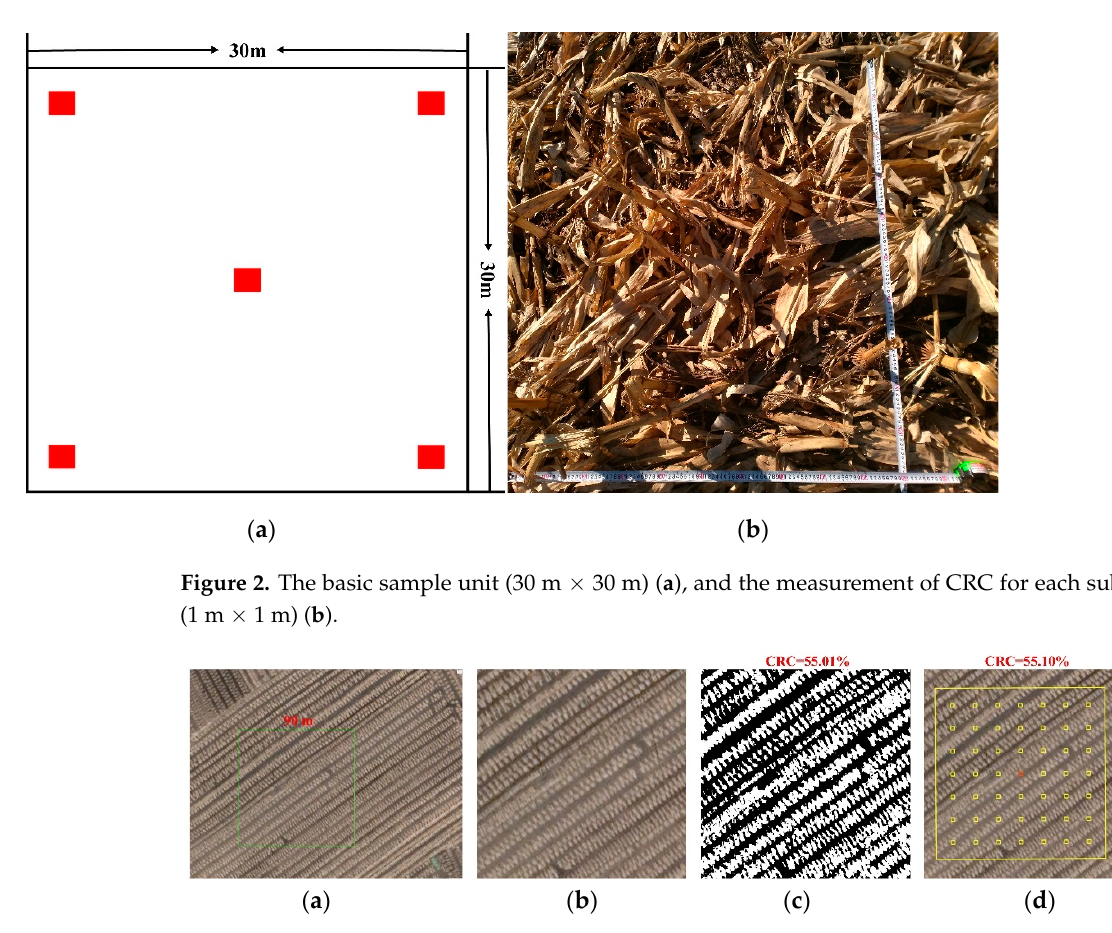
Figure 3. Illustration of the CRC assessment method using thresholding of Google Earth imagery: ( a ) Google Earth image chip, ( b ) 90 × 90 m Google Earth image chip, ( c ) CRC obtained by threshold- ing, ( d ) CRC collected on the Collect Earth sample